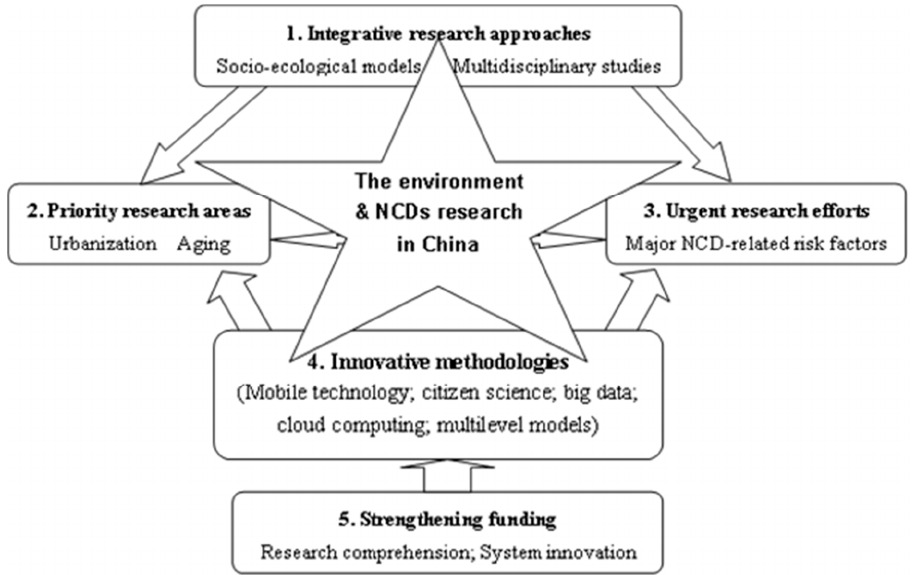
Figure 1. Comprehensive research perspectives on the environment and non-communicable chronic diseases (NCDs) in China.